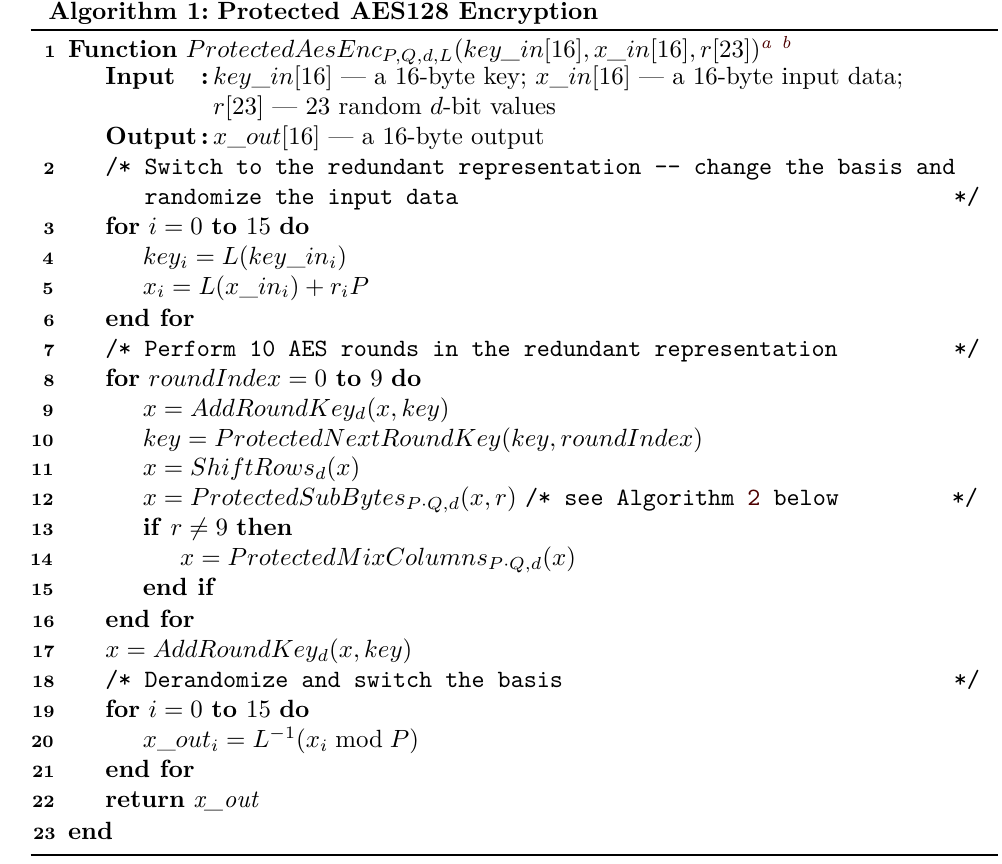
the same names, except that every byte is represented by 8 + d bits. Algorithm 1: Protected AES128